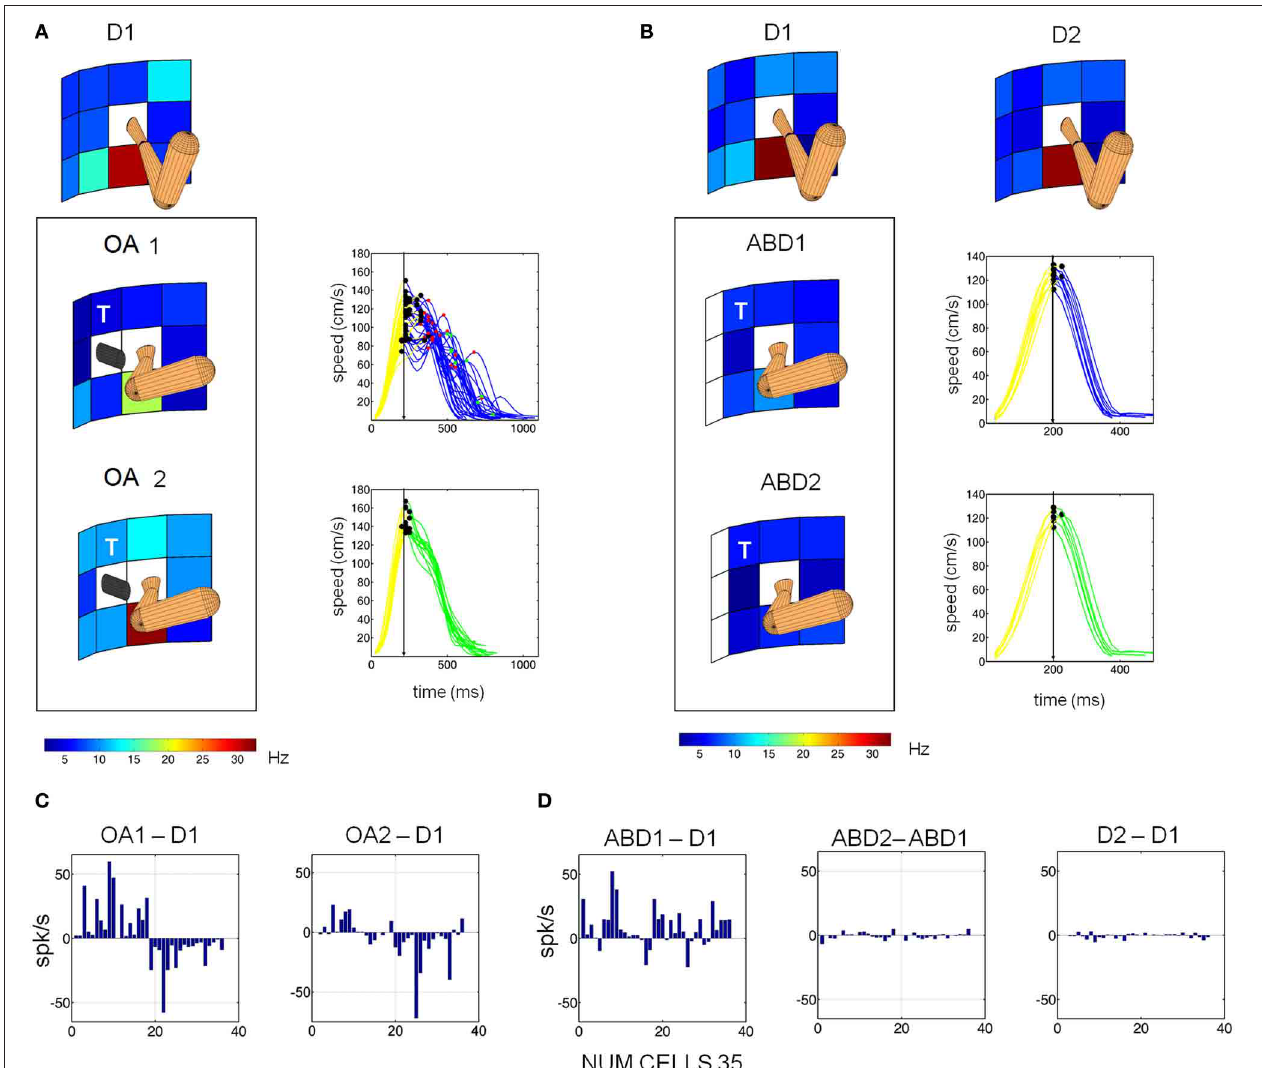
ABD2). Activity was suppressed during ABD1 but did not recover in ABD2. Hand velocity also did not evolve. (C) Bar plots of the changes in firing rate at the preferred location between OA1 and D1 (left) and OA2 and OA1 (right). Data from 35 neurons are shown. (D) Bar plots in the same format as (C) , but for the condition involving induced abduction. The “T” marks the board location for which the kinematics are